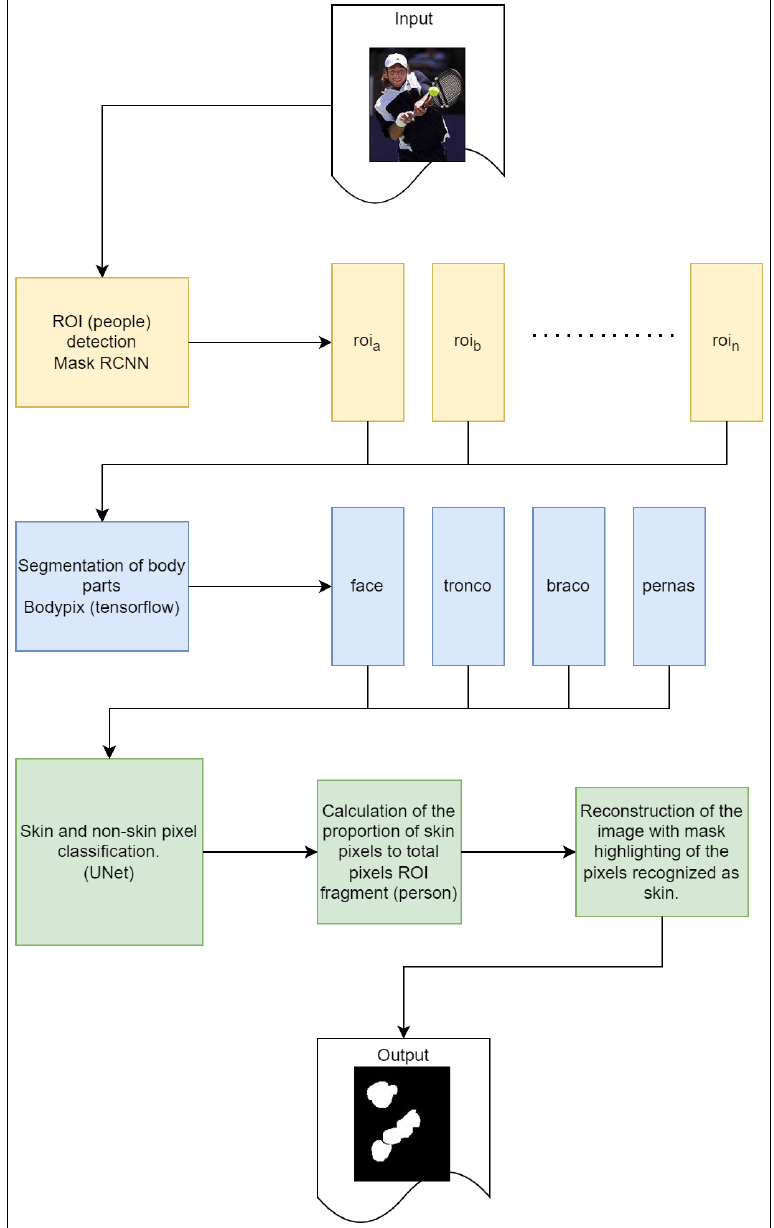
Figure 11. Diagram showing the flow of processing tasks of the proposed